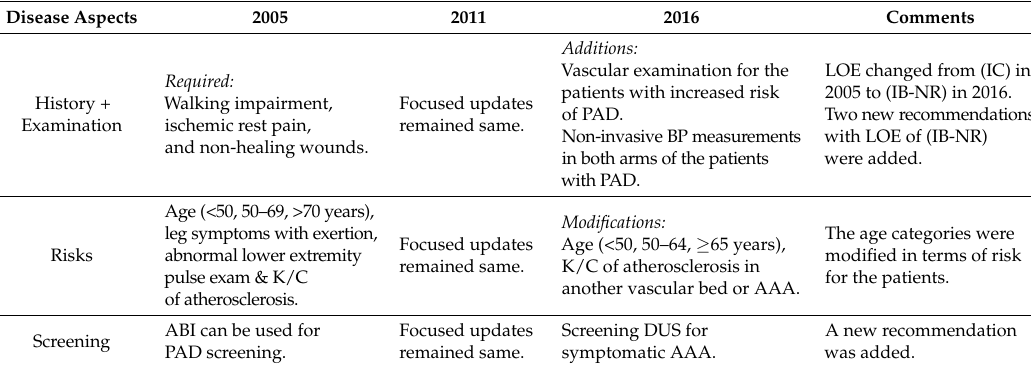
Table 1. Comparison between guidelines 2005, 2011 and 2016 in terms of history, examination and risk factors for